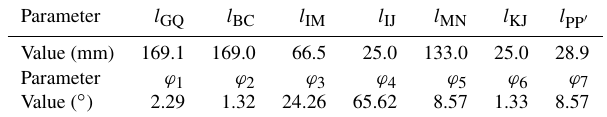
Table 1. Key parameters of the rib unit.